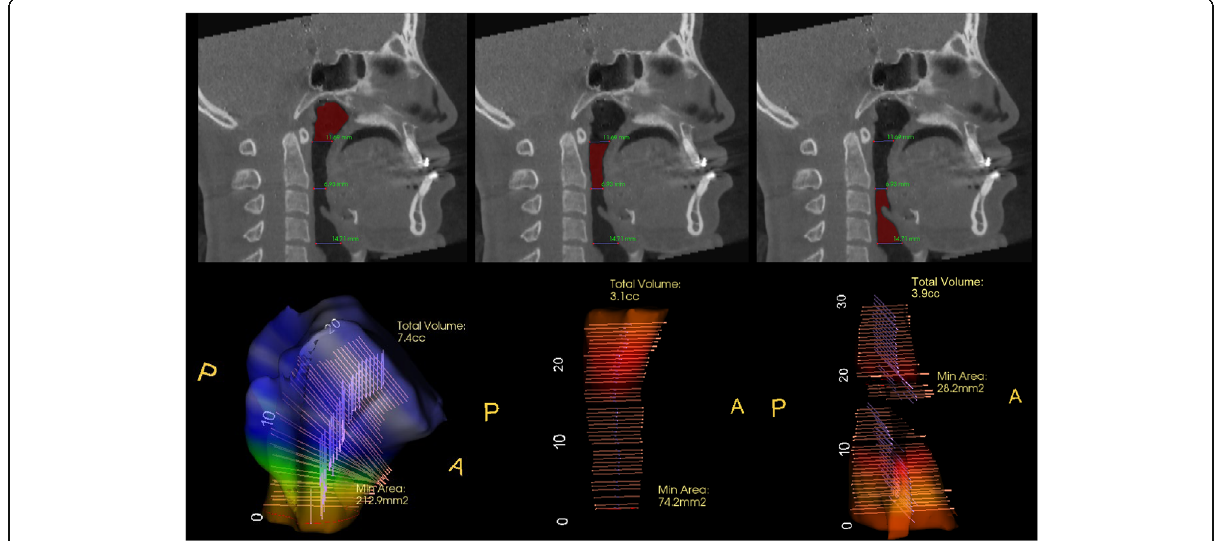
Fig. 2 Pharyngeal airway volume measurement. Volume was measured through the InVivo Dental Application version